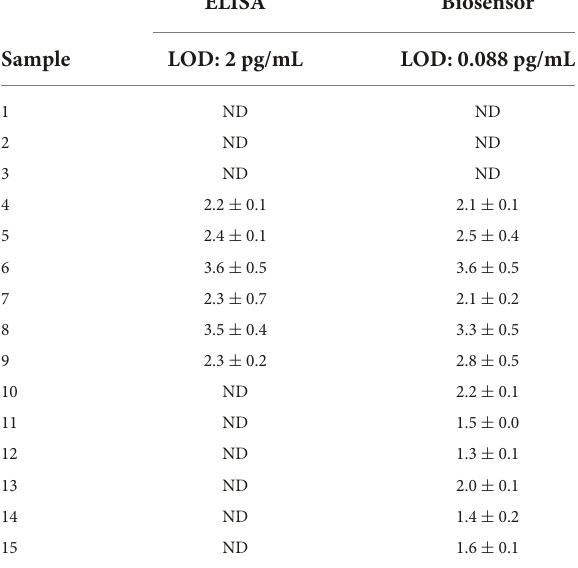
TABLE 4 Example of different patterns obtained for IL-6 concentrations measured in saliva samples, accordingly to the different sensitivity of the ELISA and biosensor assays.